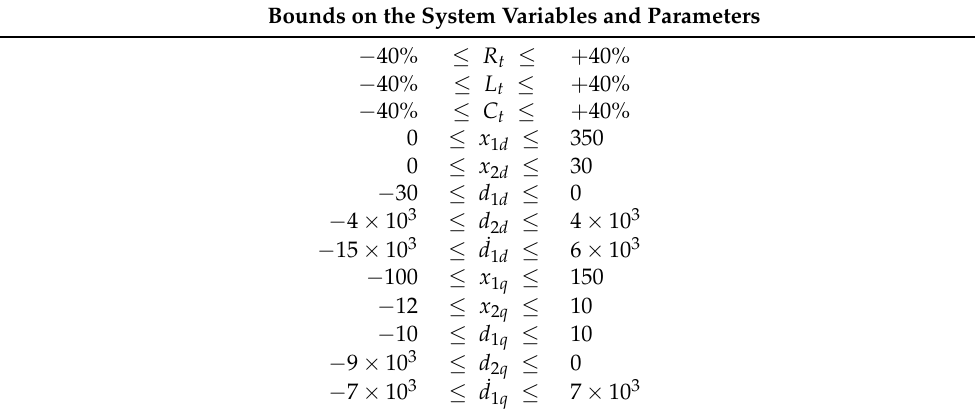
Table 5. Bounds on the system variables and parameters of the